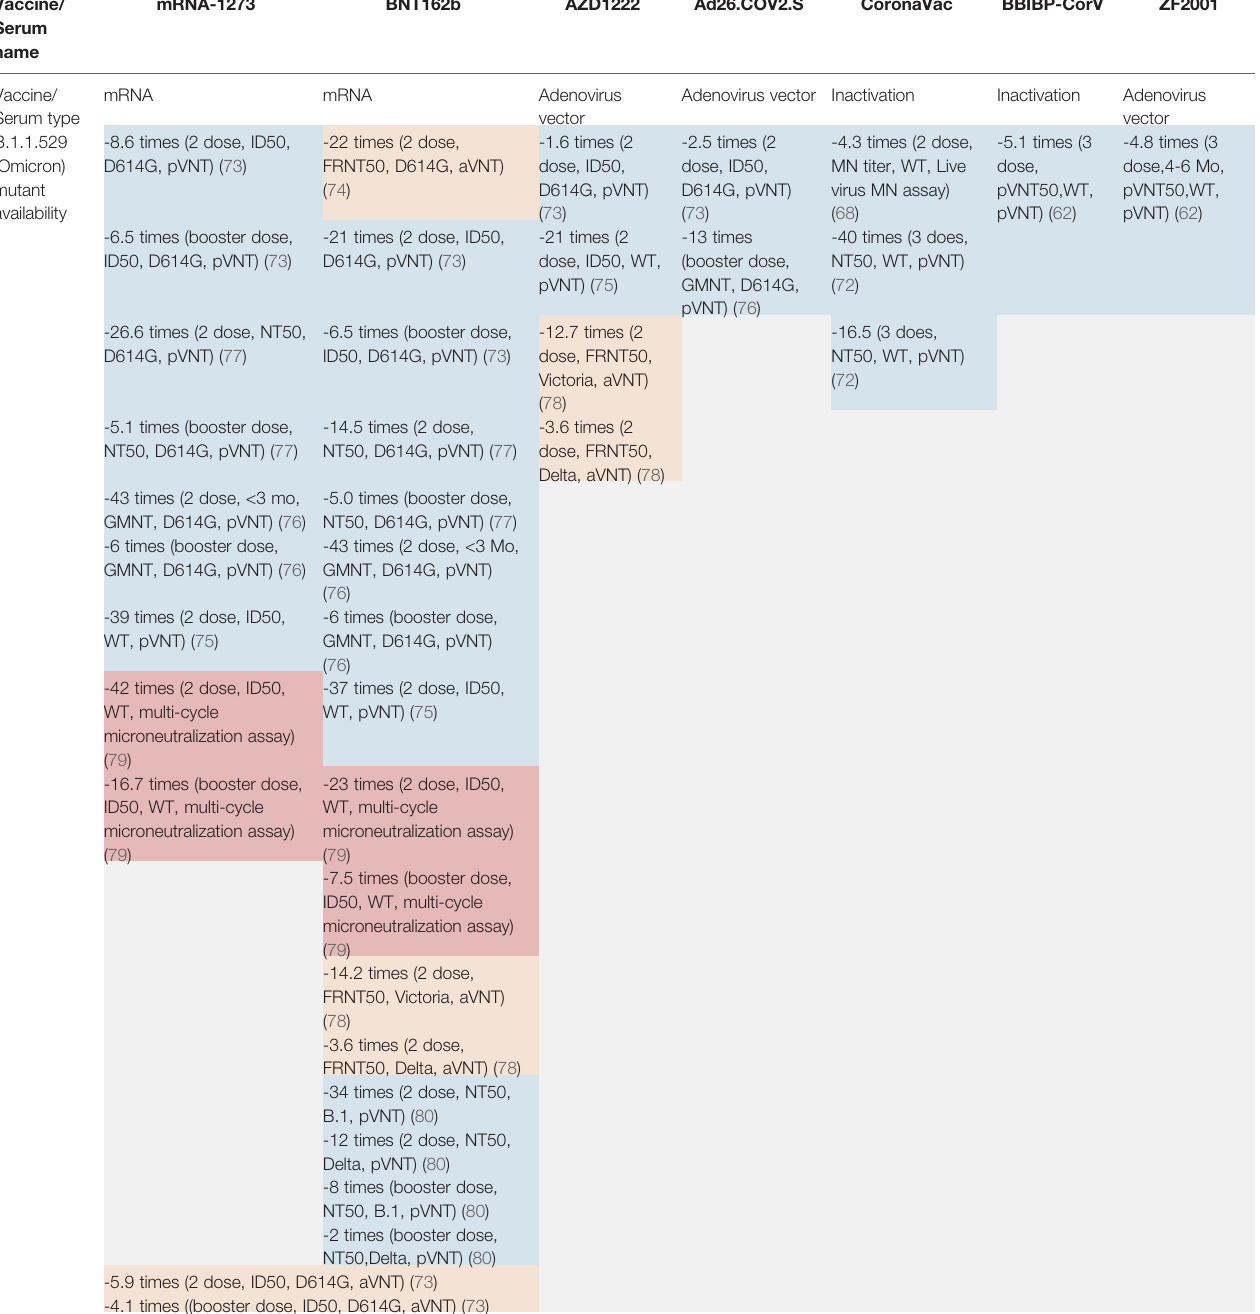
TABLE 3 | The vaccine effectiveness (VE) of different types of vaccines and serums on the omicron variant. Vaccine/